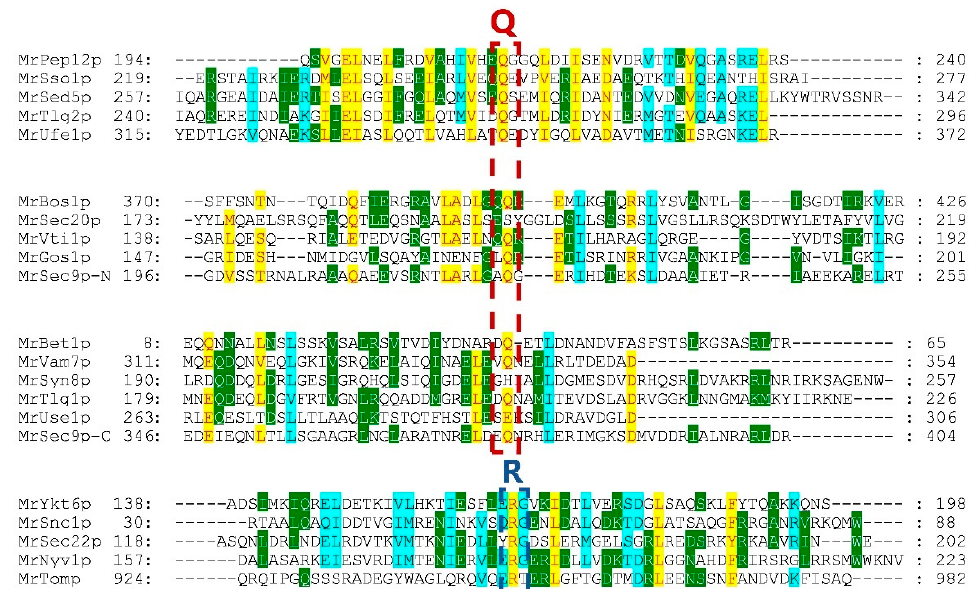
Figure 3. Identification of conserved residues of MrSNAREs. Red dotted boxes represent the conserved glutamine residue (Q), blue dotted boxes represent the conserved arginine residue (R).